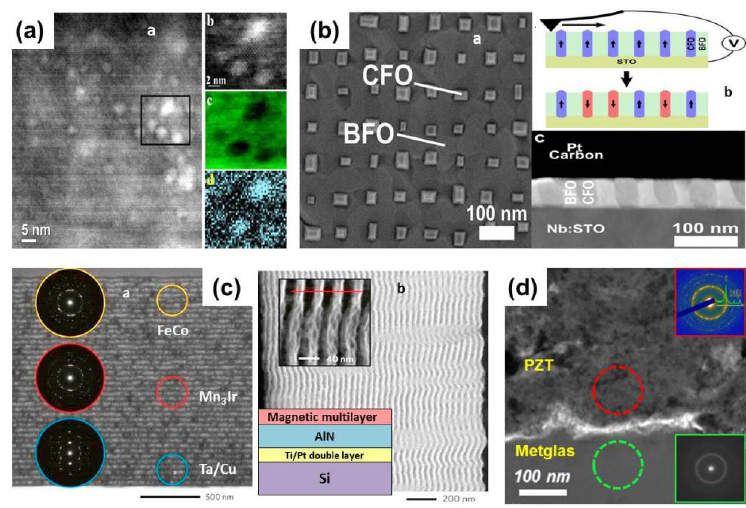
Figure 4. Development of film-based ME composites with ( a ) 0-3 connectivity [28]; ( b ) 1-3 connectivity [30]; ( c ) and ( d ) 2-2 connectivity [33,39].